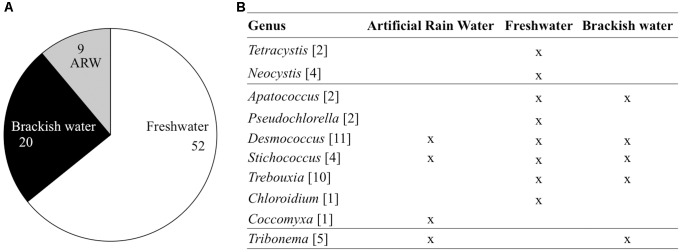
Depositional environment for the 81 airborne strains (A) and 42 strains identified down to genus level (B). The number of representatives is indicated between brackets. ARW, Artificial Rain Water.